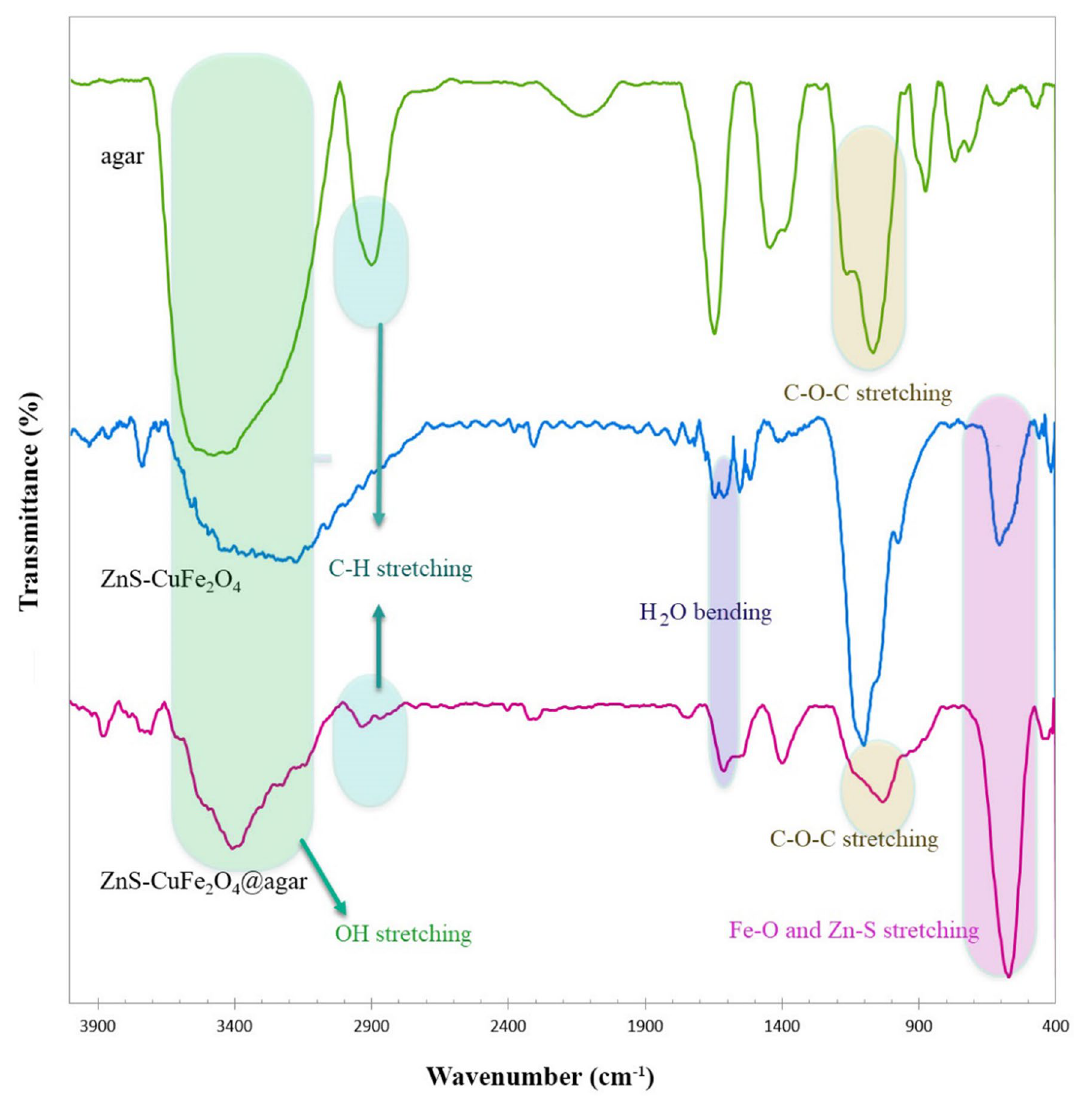
Figure 2. FT-IR spectra of the agar, ZnS/CuFe 2 O 4 and the agar supported ZnS/CuFe 2 O 4